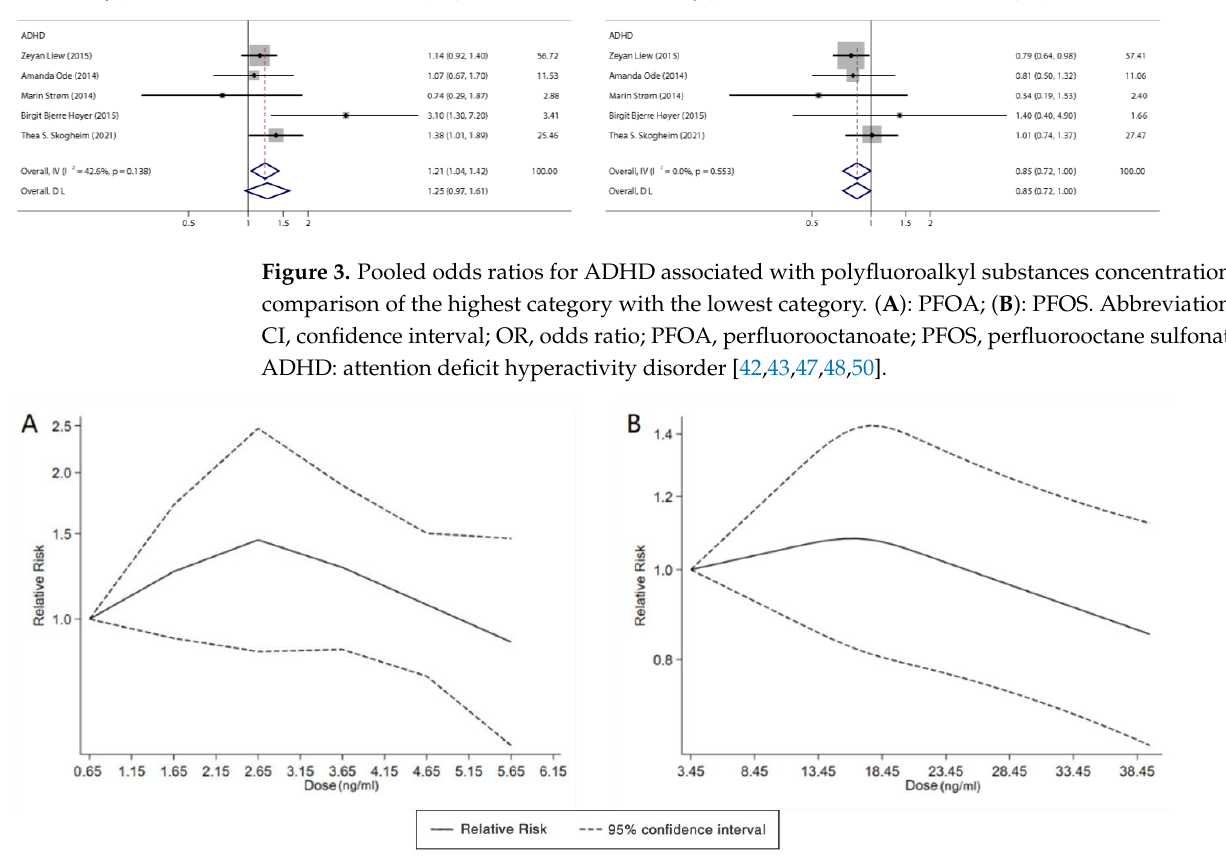
Figure 4. Dose – response relationship between polyfluoroalkyl substances and the risk of ADHD.